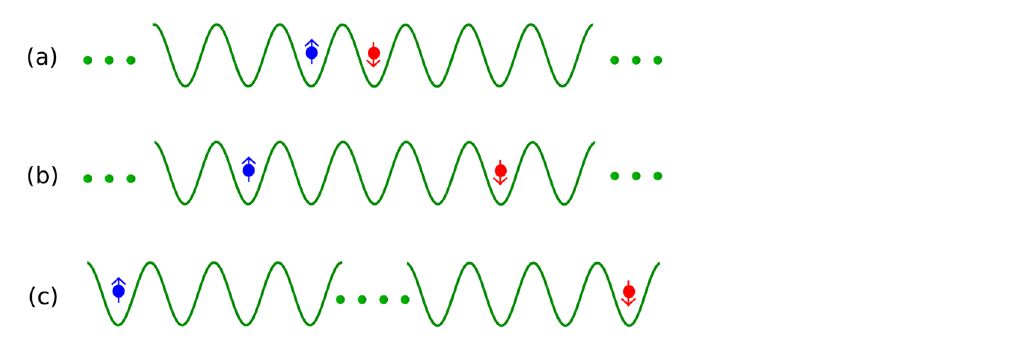
Figure 6. ( a – c ) depict the schematic description of the initial states given in Eqs. (11), (12) and (13)